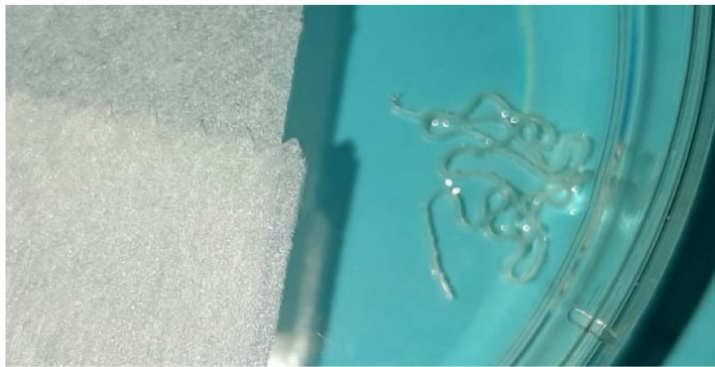
Figure 2. Parasite in saline in the Petri